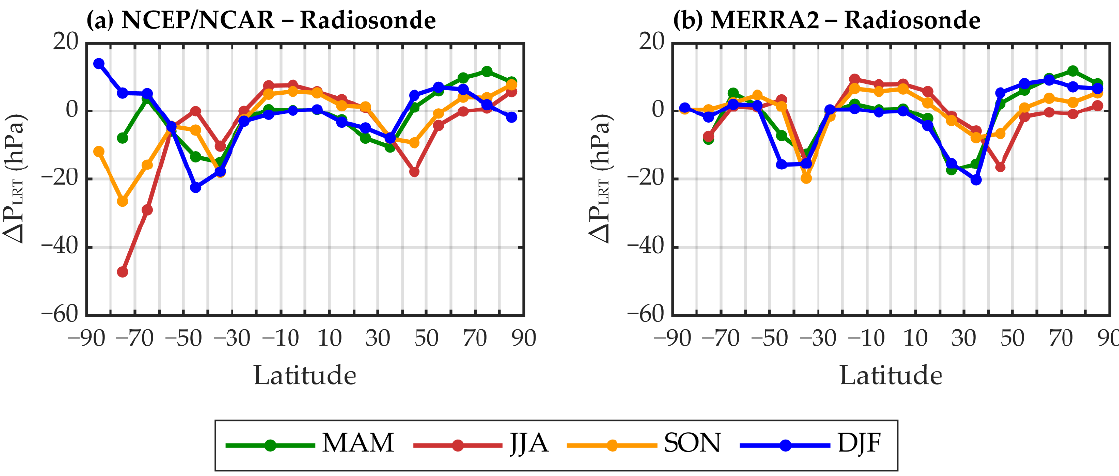
Figure 4. ( a ) Latitudinal variation in the P LRT difference ( ∆ P LRT , in hPa) between NCEP/NCAR and radiosonde data averaged over 1980–2017 in the four seasons. ( b ) The same as ( a ), but for the P LRT differences between MERRA-2 and radiosonde data. The NCEP/NCAR and MERRA-2 data are used in their original resolutions of 2.5 ◦ × 2.5 ◦ and 0.625 ◦ × 0.5 ◦ in longitude and